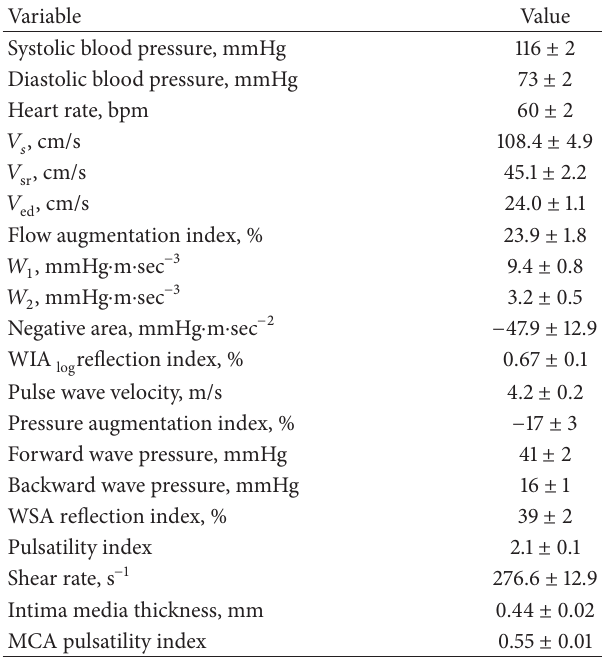
Table 1: Carotid hemodynamic values (mean ±